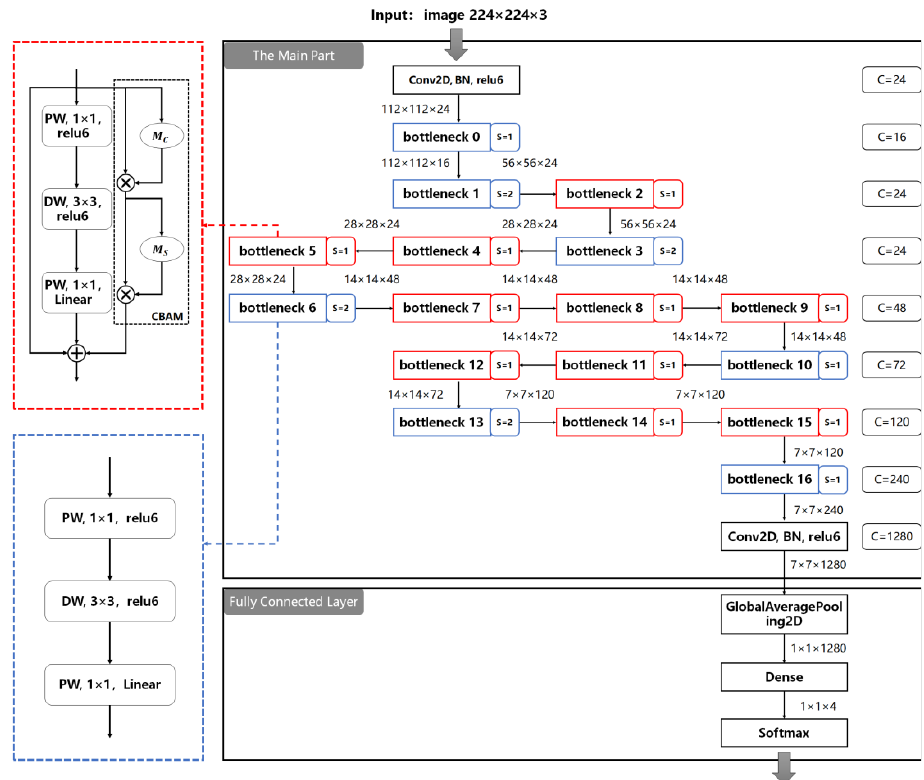
Figure 4. Model structure of improved MobileNetV2.